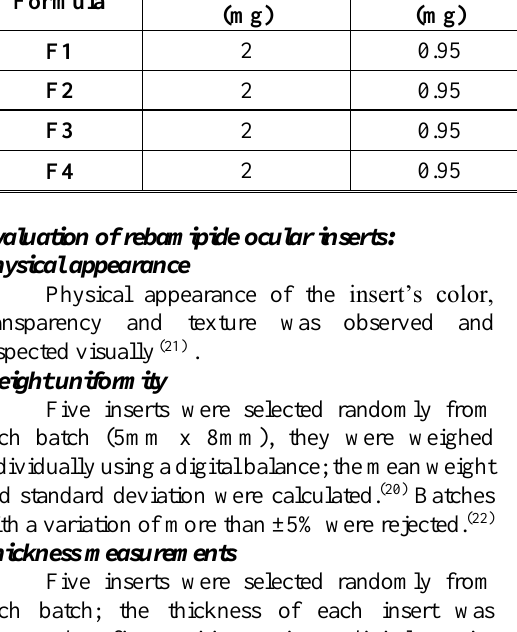
Table( 1) Composition of formulas of matrix rebamipide ocular inserts